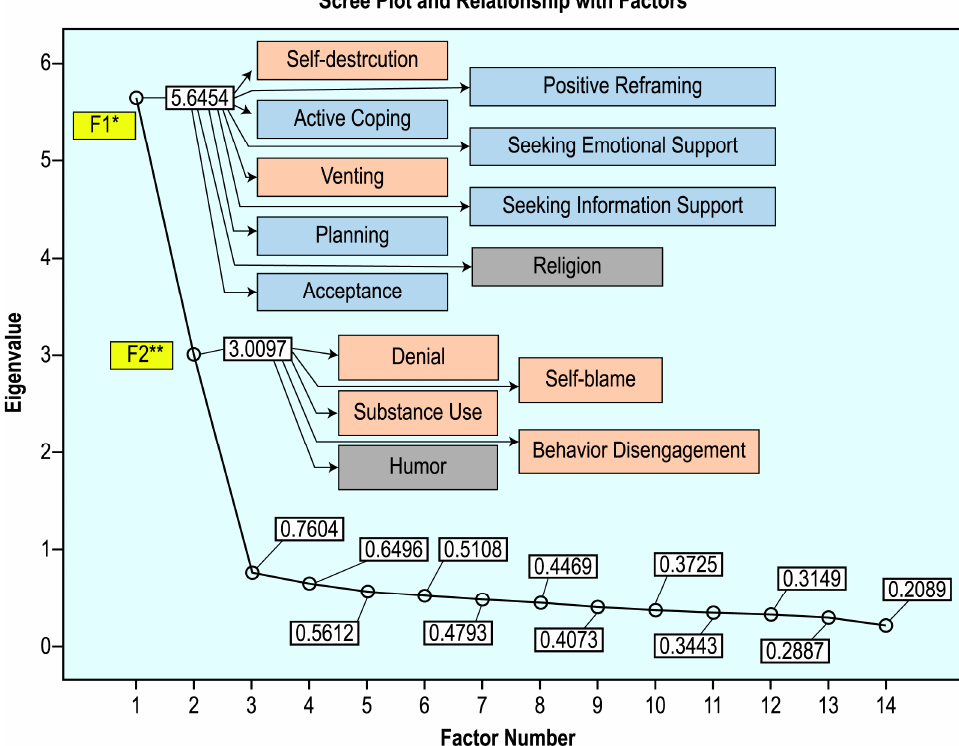
Figure 4. Exploratory factor analysis of categories of coping strategy . * F1, Factor 1 as 1st cluster of adopted coping strategies; ** F2, Factor 2 as 2nd cluster of adopted coping strategies; orange colored rectangles, negative coping approaches; blue colored rectangles, positive coping approaches; violet colored rectangles, neither positive nor negative approaches;.